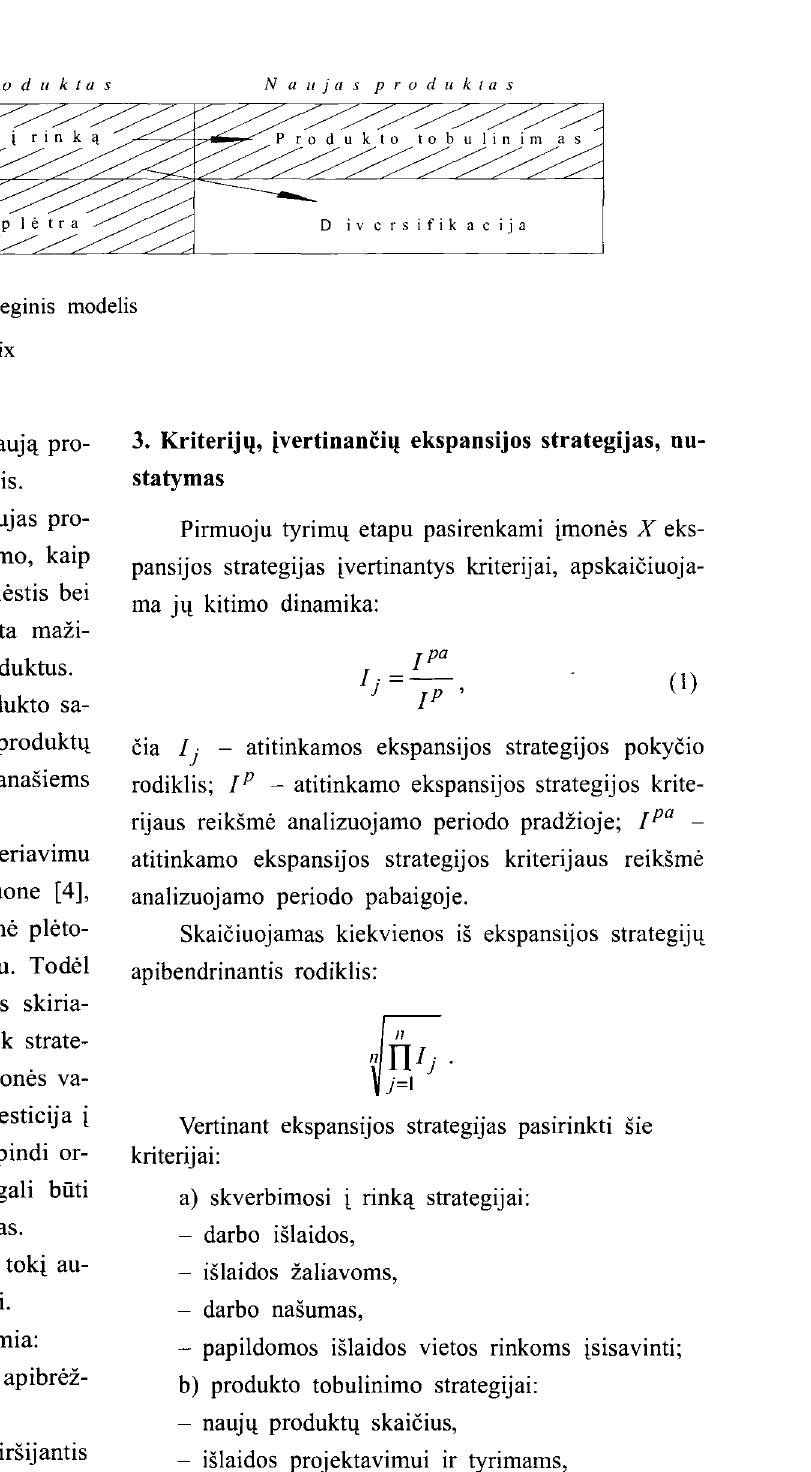
Fig 1. Ansoff's product-market matrix